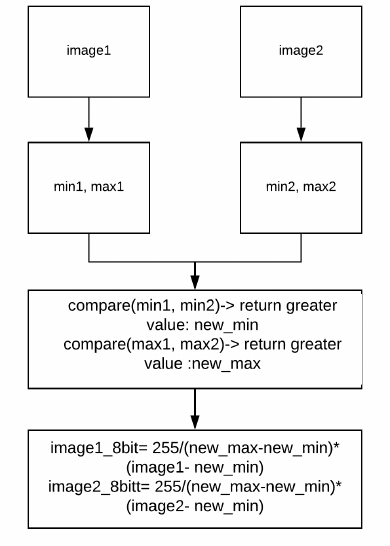
Figure 4. The 14 bit to 8 bit downsampling technique from